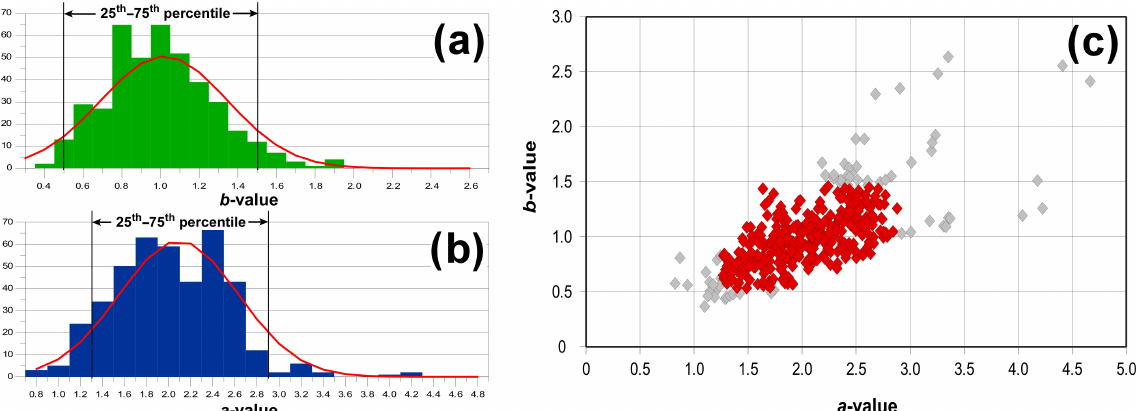
Figure 7. (a, b) Histograms showing the frequency distribution of b and a values. (c) Plot of a and b values obtained for the grid nodes; discarded values are in gray.